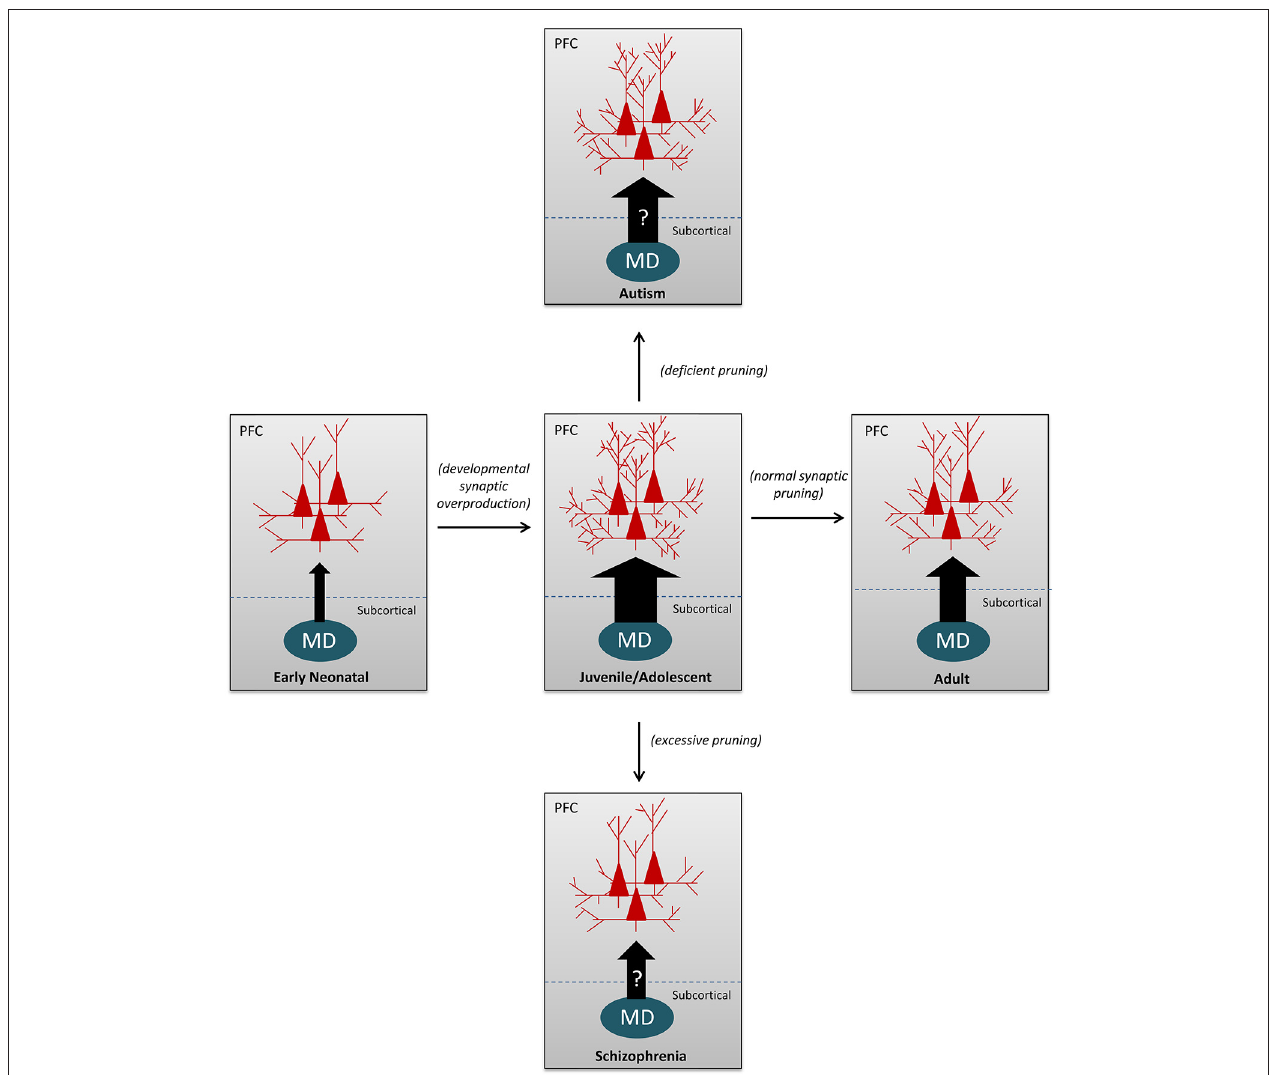
periods, and then reduced to normal levels in adulthood by eliminating the excess presynaptic axonal arbors (thalamocortical fibers) and/or postsynaptic dendrites. In contrast, as speculated, decreases in MD activity could result in a loss of synaptic drive to the PFC early in development, leading to a decrease in synaptic density, as is observed in patients with schizophrenia. Conversely, a presumably overactive thalamocortical drive to the PFC, could lead to a failure of the normal developmental synaptic pruning, resulting in increased spine density or hyperconnectivity, as demonstrated in